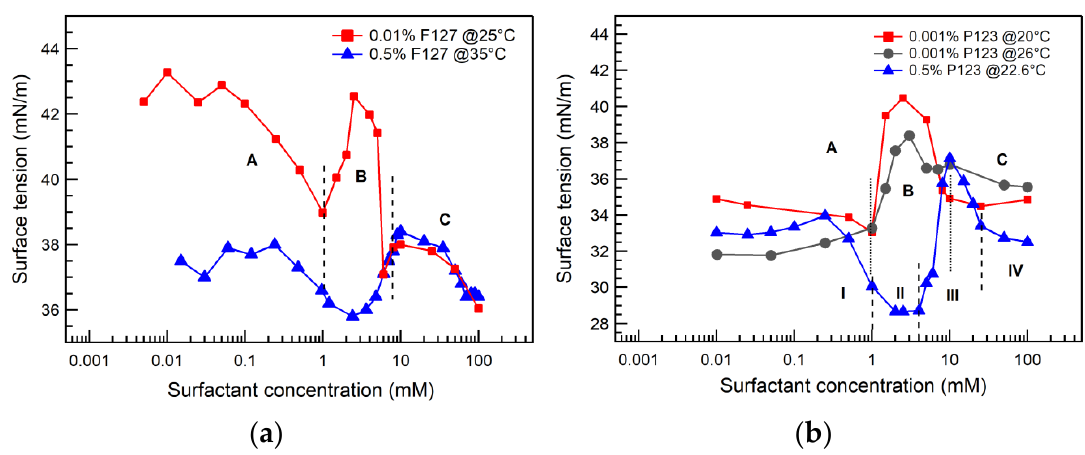
Figure 3. Surface tension of SDS aqueous solutions in the presence of ( a ) 0.01% Pluronic F127 (at 25 ± 0.6 °C), 0.5% Pluronic F127 (at 35 °C, micellized), or ( b ) 0.001% Pluronic P123 (at 20 °C and at 26 ± 0.6 °C), 0.5% Pluronic P123 (at 22.6 °C), plotted as a function of the SDS concentration. The SDS + 0.5% Pluronic F127 surface tension data are from the literature [37]. The vertical dotted lines indicate SDS concentration regions that correspond to different stages of PEO-PPO-PEO block copolymer and ionic surfactant interactions, as described in the Results and Discussion section and depicted in Figure 6.